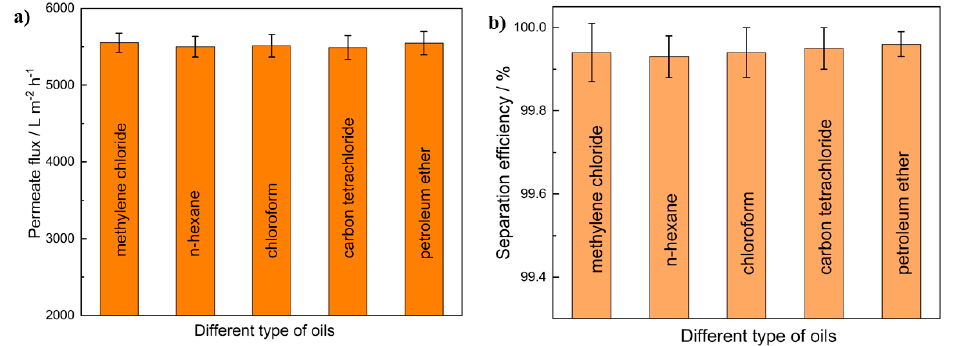
Figure 7. ( a ) Separation fluxes and ( b ) efficiencies of DP8–1.5 layered membrane for different oils.